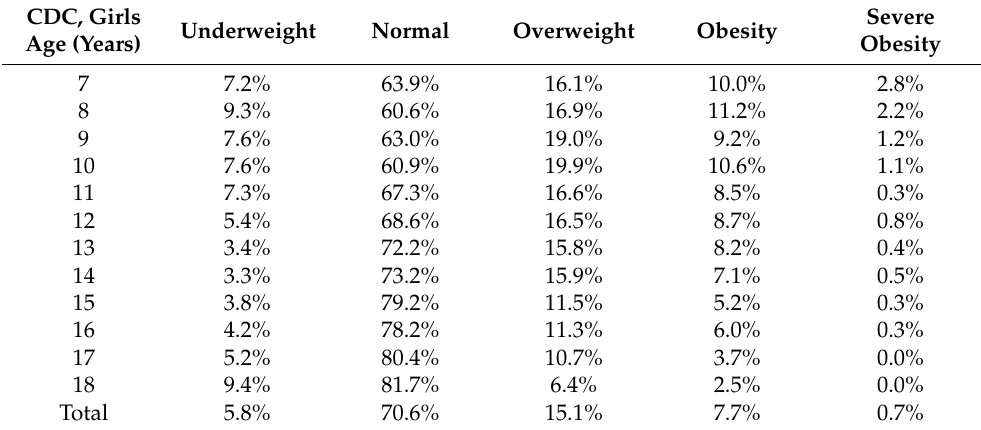
Table 7. Underweight, overweight and obesity prevalence in girls, according to the age, using CDC percentile reference.